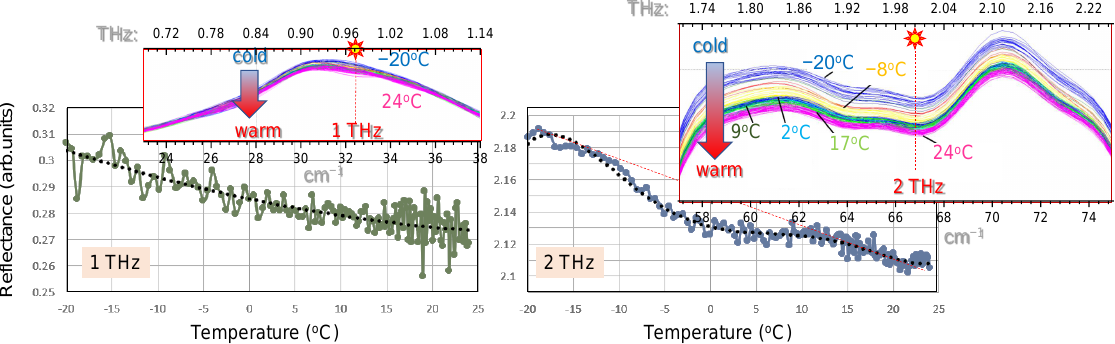
Figure 3. Temperature dependence of butter sample (2-mm-thick) at 1 and 2 THz measured with Au top-mirror [15]; wavelength of 1 THz is 0.3 mm and 2 THz is 0.15 mm. The insets show the reflectance intensity vs. the wavenumber; air (no Au top-mirror) reflectance is taken as the reference. Dotted-lines (black) are eye guide splines of the experimental